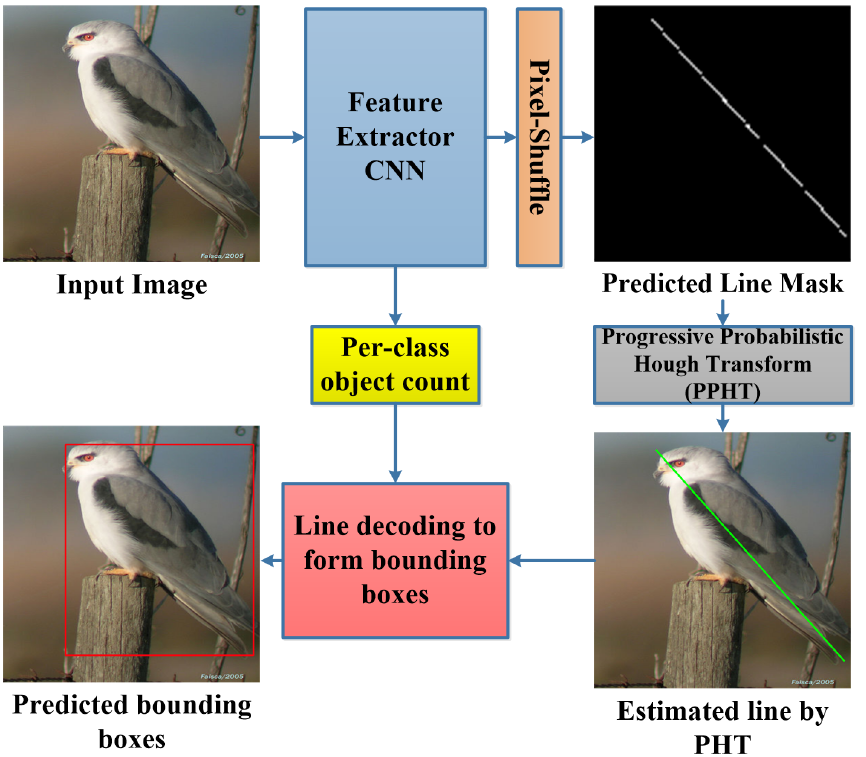
Figure 1. Overview of the proposed object detection method using line-encoded bounding